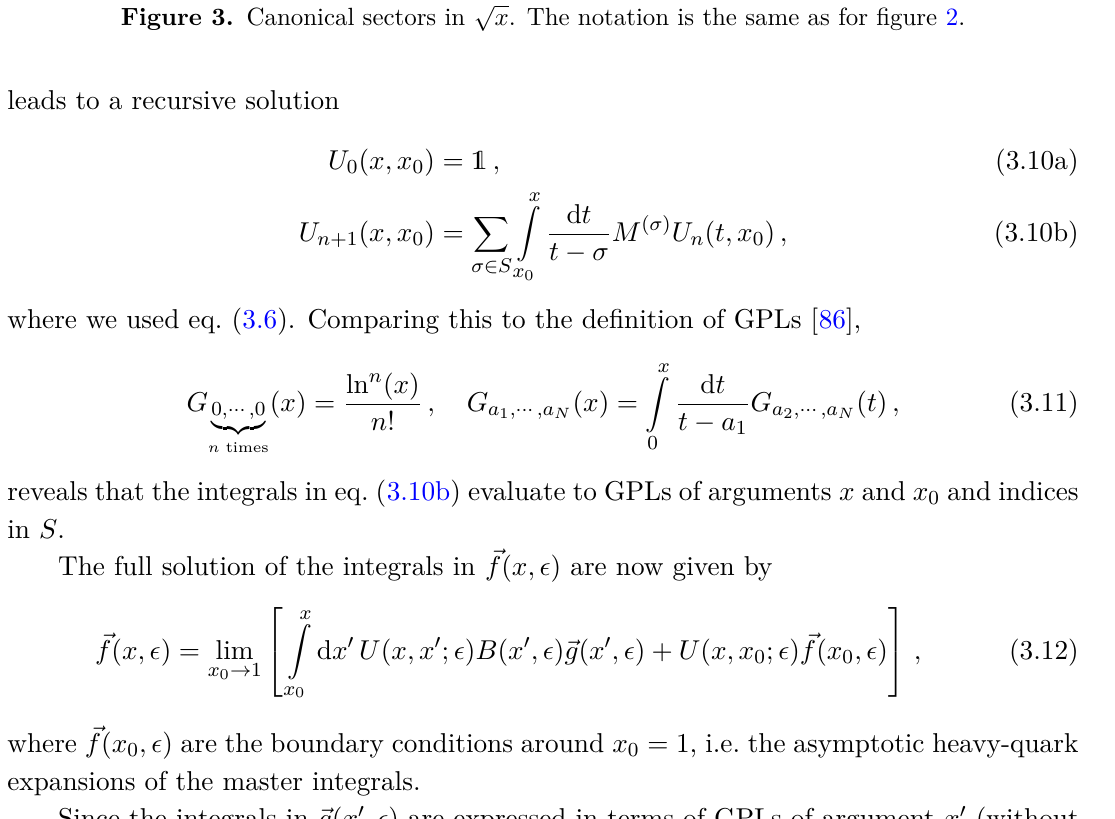
Figure 3. Canonical sectors in